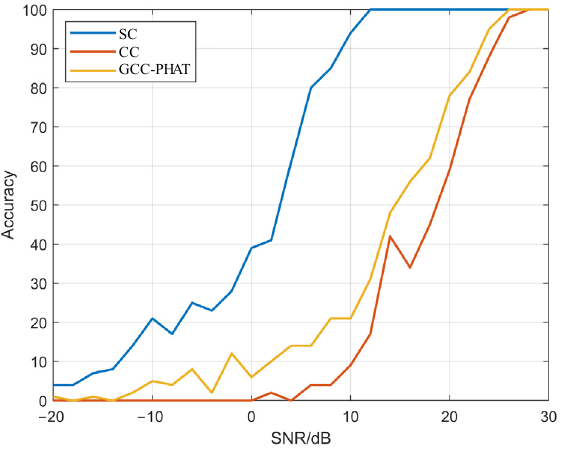
Figure 4. Time delay values calculated by three methods when the SNR is 0 dB ( a ) and 20 dB ( b ).